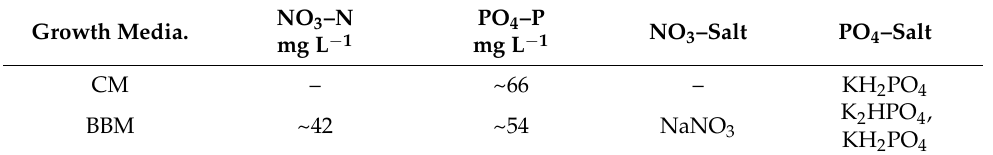
Table 2. NO 3 –N and PO 4 –P concentrations in respective standard media and the corresponding salts. Growth